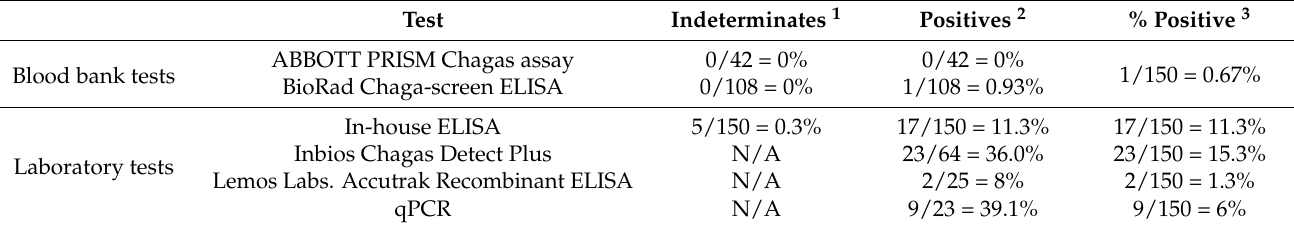
Figure 2. CD test results of participants with positive or indeterminate results by in house ELISA. * Blood bank tests include: ABBOTT PRISM Chagas assay or BioRad Chagascreen ELISA. Of these, 12 were positive by the WHO-defined criteria of having at least two different serological tests in agreement; nine were positive by qPCR. Three participants could not successfully be reached for further blood draws, and so no sample was available to run PCR on these patients. The country of origin of these patients is indicated at the top of the figure (Colombia, left; Mexico, right). Table 1. Positive results by test